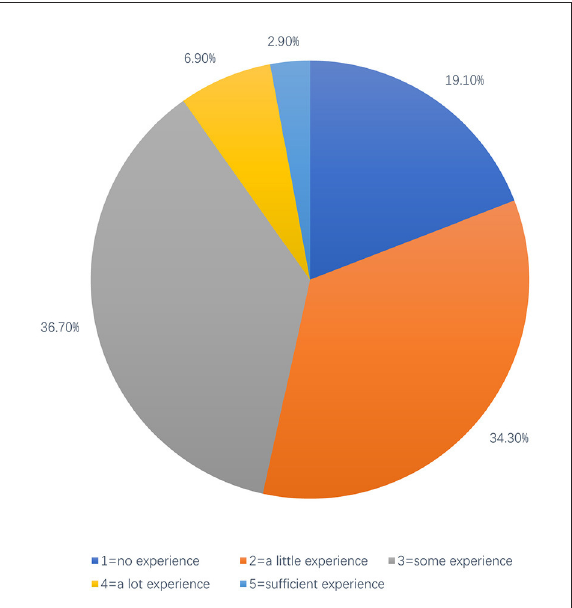
FIGURE2 Postgraduate medical students self-reported degree of clinical